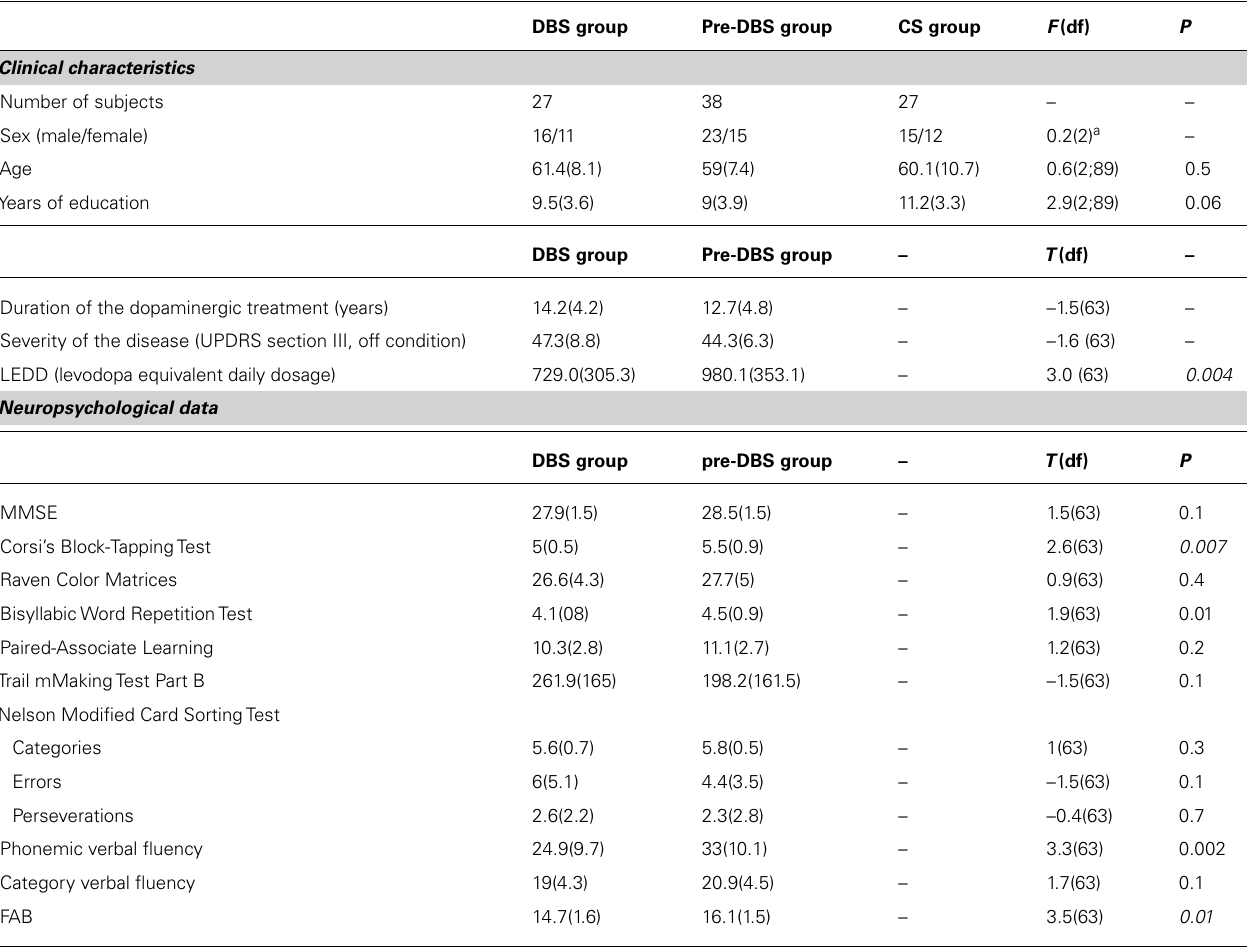
Table 1 | Clinical characteristics and neuropsychological data of the DBS, pre-DBS, and C